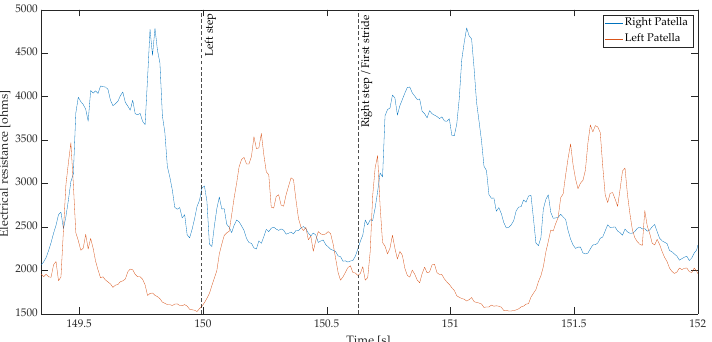
Figure 6. Sample of collected textile pressure sensor raw data located over a participant’s patellas during two